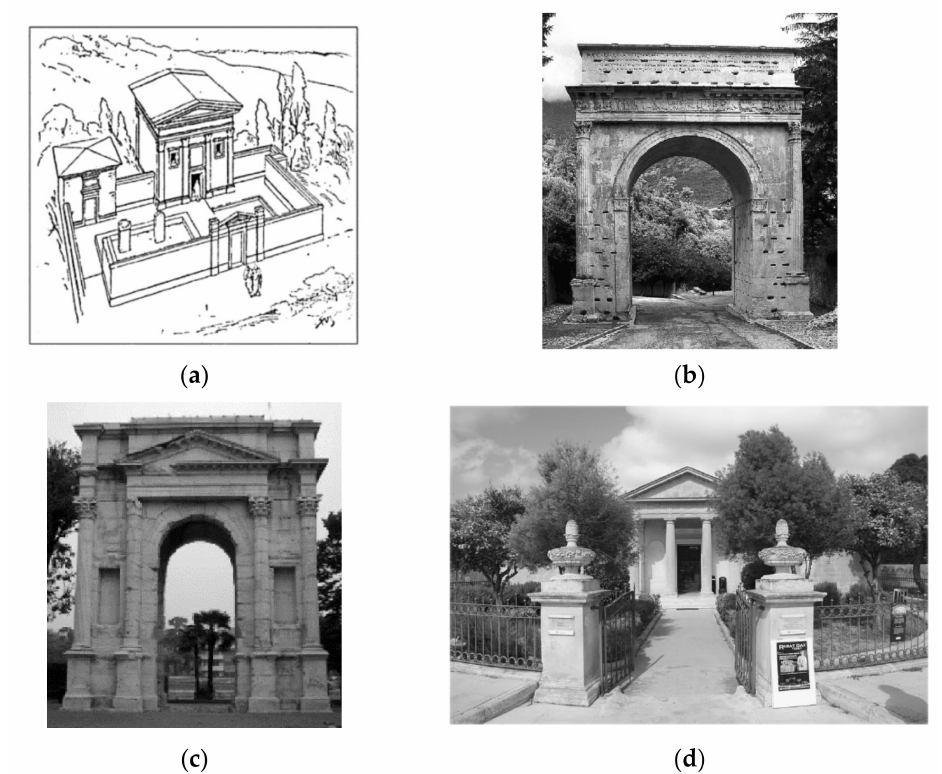
Figure 5. Reconstruction of the Aedificium Monumentalis : ( a ) axonometric sketch by Christian Carl Friedrich Hülsen [29]; ( b ) the Arch of Susa at the foot of Mont Cenis, dedicated to Augustus; ( c ) the Arco dei Gavi, which was built along the Via Postumia in Veronanella; and ( d ) reconstruction of the Domus Romana, today the archaeological museum of the island of